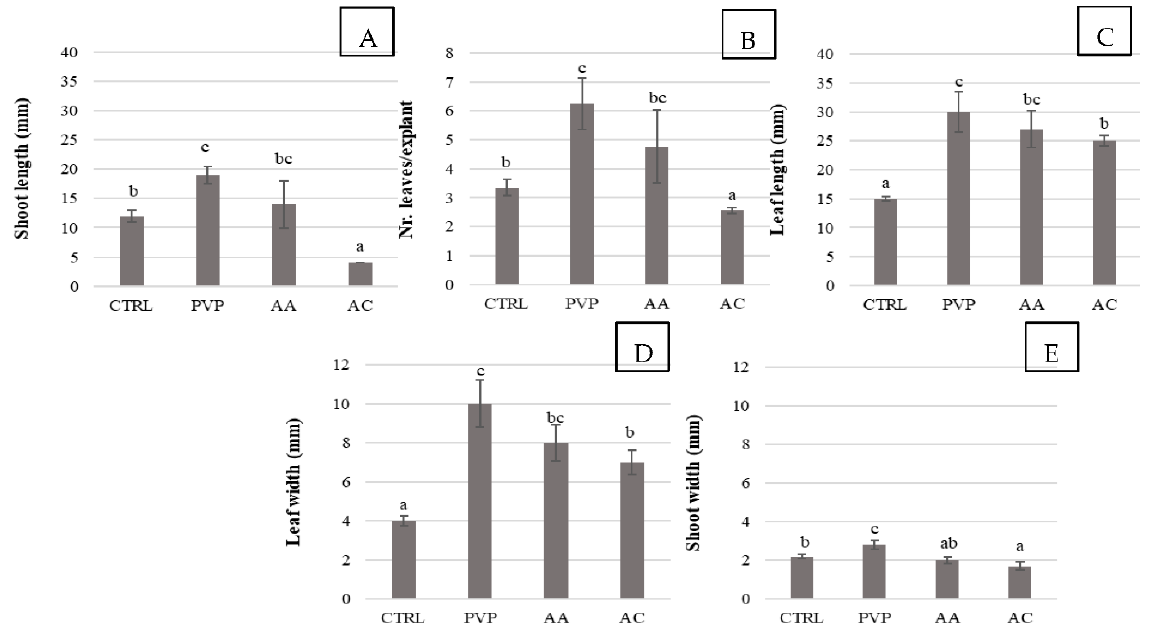
Figure 3. Effect of different polyphenol controlling agents on shoot proliferation of chestnut cv. ‘Garrone Rosso’. ( A ) Shoot length, ( B ) nr. of leaves per explant, ( C ) leaf length, ( D ) leaf width and ( E ) shoot width. CTR: control medium, a medium without any polyphenol controlling agents; PVP: 500 mg/L polyvinylpyrrolidone; AA: 100 mg/L ascorbic acid; AC: 1 g/L activated charcoal. Data are the means of three biological replicates (15 nodal explants each) ± SE. Means with the same letter do not significantly differ at p ≤ 0.05 (Tukey’s HSD test).